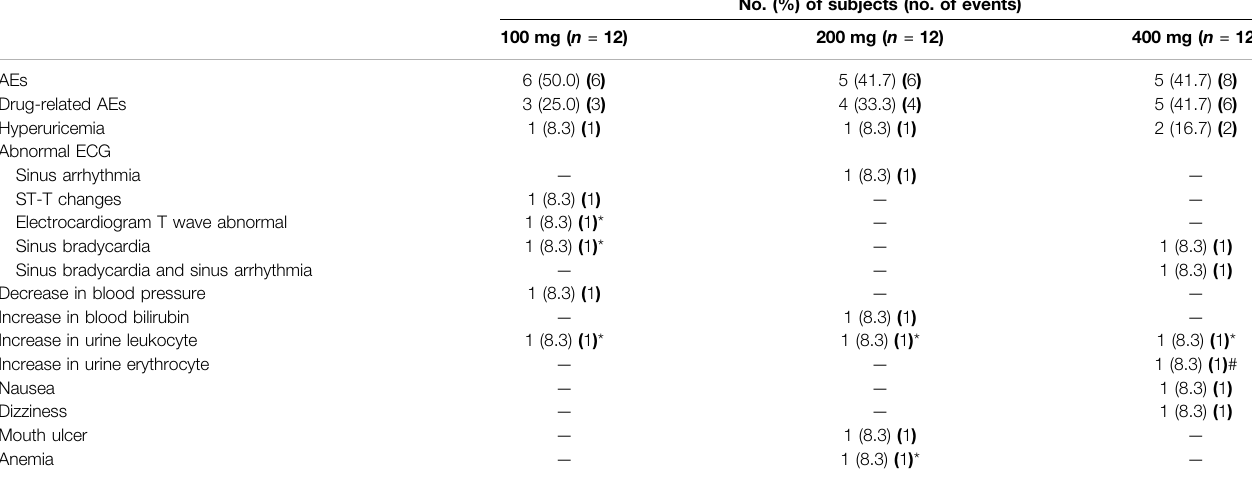
TABLE 5 | Summary of AEs for all treated